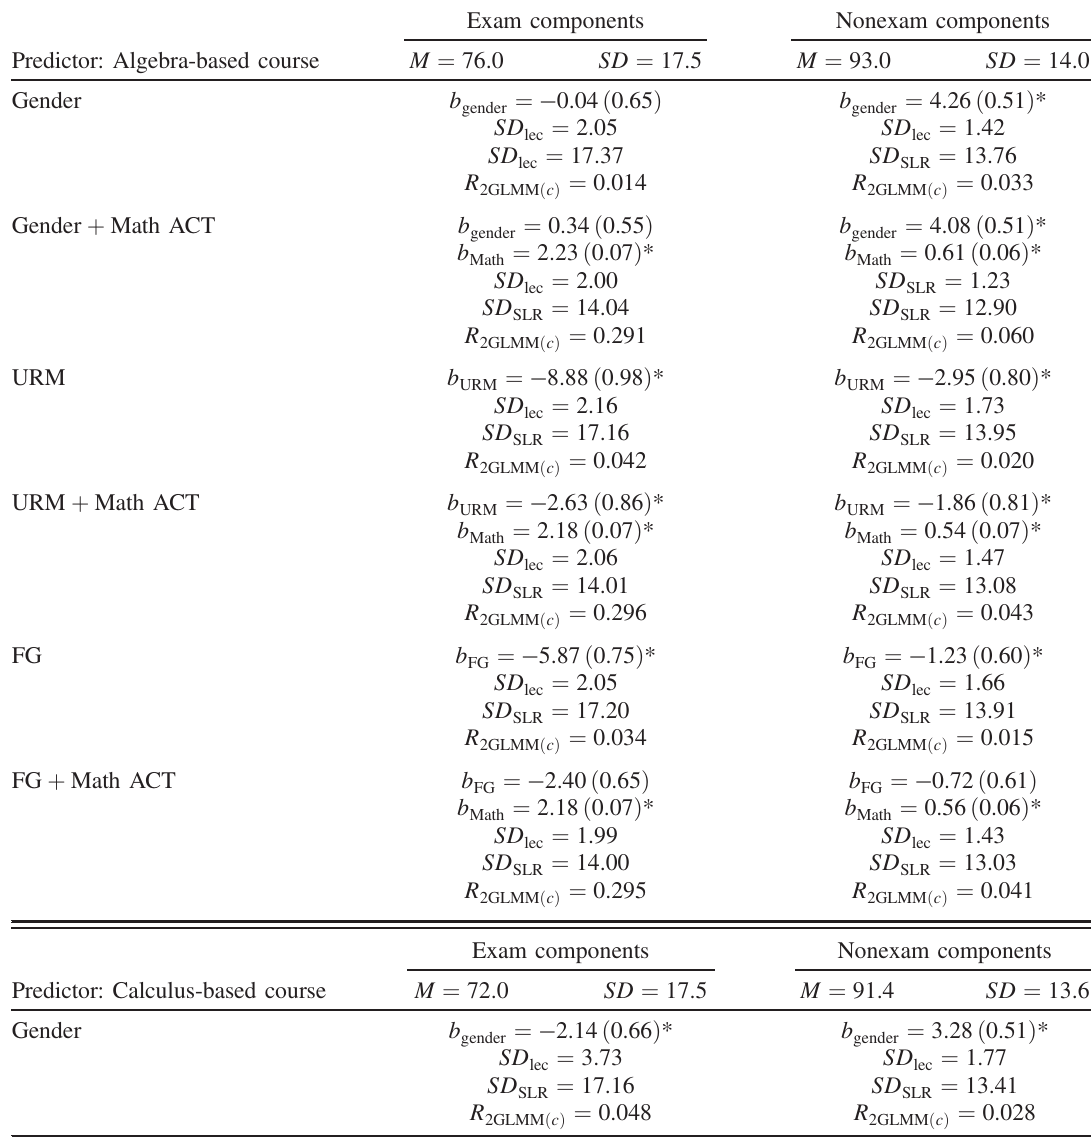
TABLE IV. Nonstandardized multilevel model fixed effects estimates with standard errors reported in parentheses. A significance of p < 0 . 05 is indicated by *. The random effect of lecture section and the student-level residual standard deviations are reported in italics. The maximum score on components is 100 (percent), and units of all numbers are in these